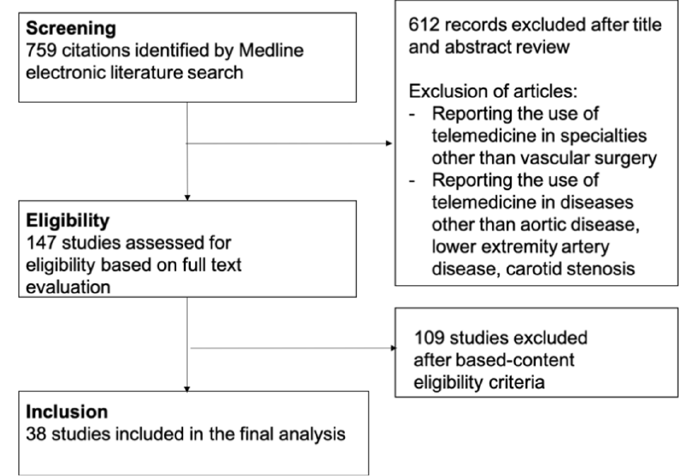
Figure 1. Flow chart depicting the process for the literature search and selection of the studies .